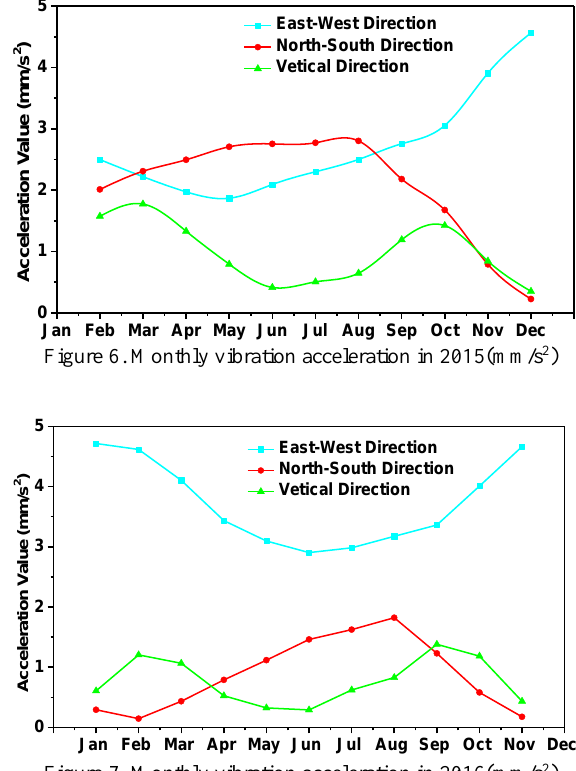
Figure 9. Daily vibration acceleration in special holidays(mm/s 2 ) According to Figure 9, we can see that the three-dimensional vibration acceleration on October 1 (National Day) changed obviously compared three days before and after that day, and the vibration acceleration in east - west direction increased significantly; The vibration acceleration in north - south direction and vertical direction decreased obviously, which indicates that the increasing visitor flow during holidays had a significant effect on the vibration of the Grand